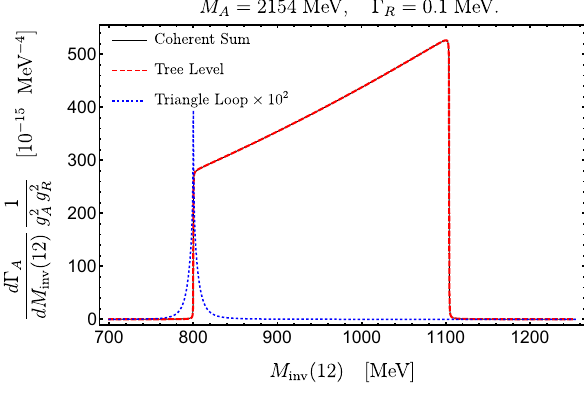
1 Fig. 12 d (cid:4) A as a function of M inv ( 12 ) with M A = dM inv ( 12 ) g 2 A g 2 R 2154 MeV and (cid:4) R = 0 . 1 MeV. The dashed and solid lines are indis- tinguishable in the